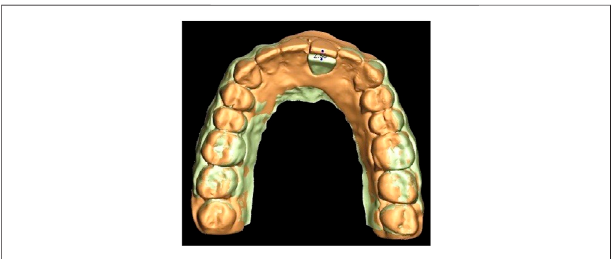
FIGURE 2 | Superimposition of the typodont scans before and after testing of the 4D aligner, scan 1 (before, green) and scan 2 (after, orange).